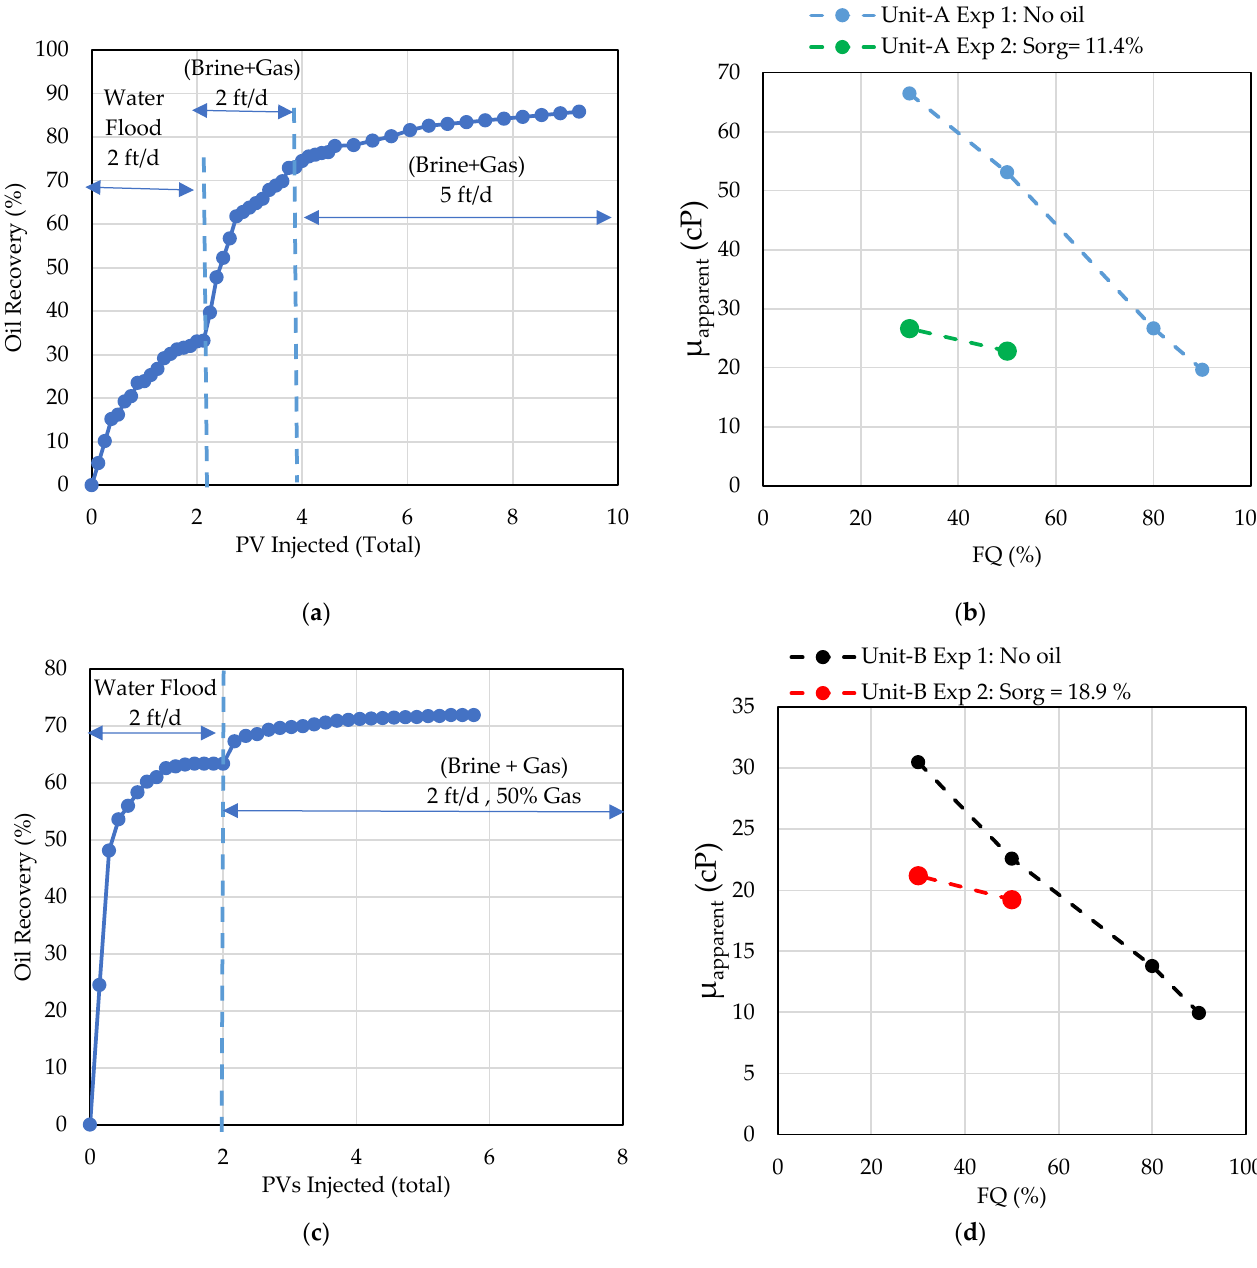
Figure 7. Results of Unit-A Exp 2: ( a ) oil recovery (%), and ( b ) apparent viscosity at 2 ft/d and Sorg = 11.4%. Unit-B Exp 2 results: ( c ) oil recovery (%), and ( d ) the apparent viscosity at 2 ft/d and Sorg = 18.9%. Gas-brine flooding is at 50% injection gas fraction.